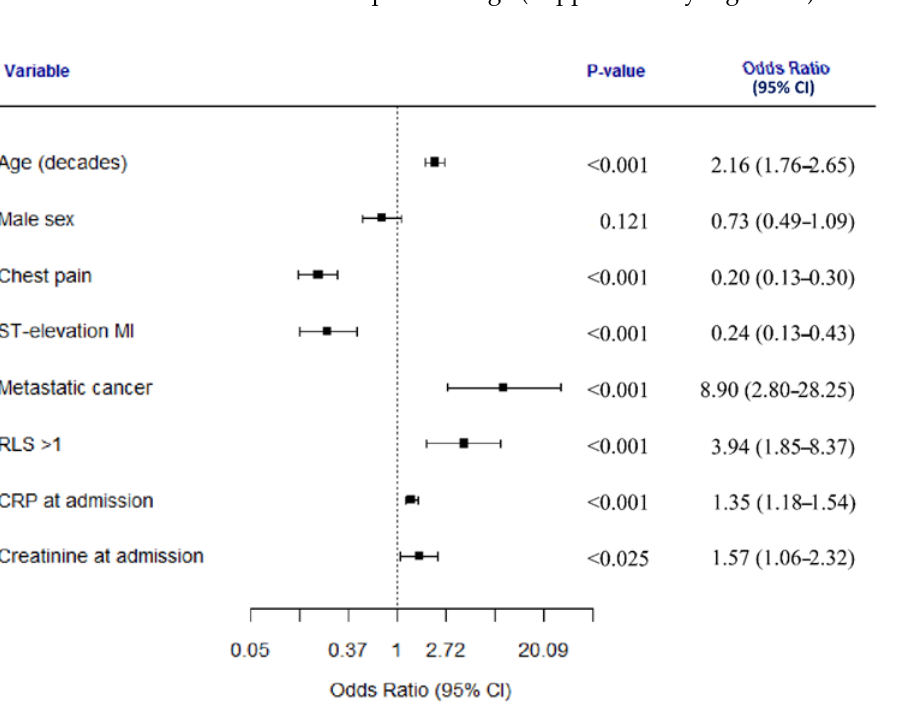
Figure 4. Predictors of treatment outside a cardiology department. Male sex and variables independently associated with treatment outside a cardiology department are presented in the figure. RLS—reaction level scale, CRP—C-reactive protein.